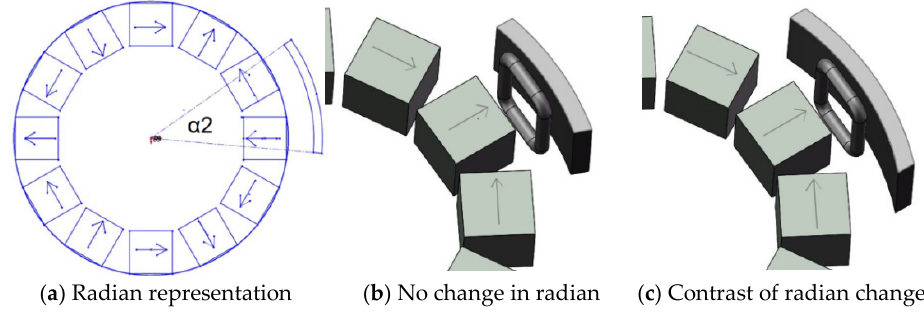
Figure 6. The radian of iron sheet.